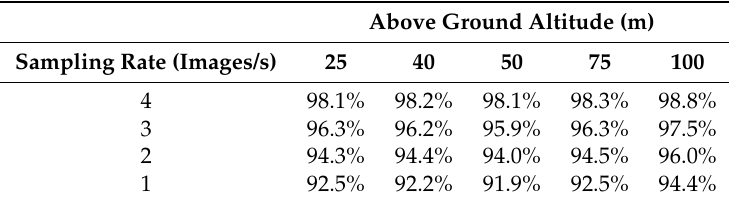
Table 2. Forward overlap resulting from different image sampling